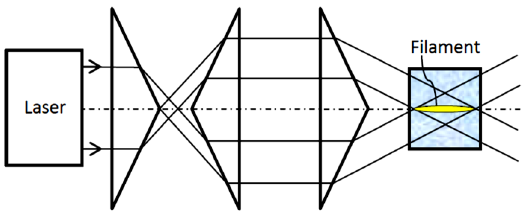
Figure 3. Schematic of producing the extended-length focusing inside the transparent material employing